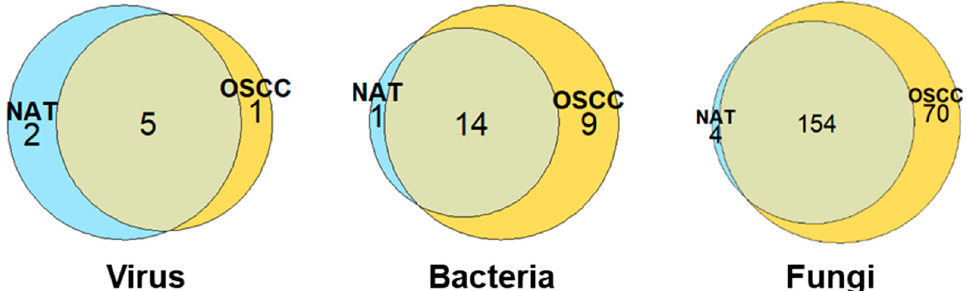
Figure 1. Distribution of microbial species between NAT and OSCC conditions: Venn diagrams displaying number of viral, bacterial, and fungal species identified by at least two unique proteins and their allocation to NAT, OSCC, or both conditions based on log-fold change cut-offs. Species inferred by proteins with a mean intensity log 2 fold-change of ≤− 1 or ≥ 1 were assigned to NAT and OSCC conditions, respectively, with those between this range being considered present in both conditions.